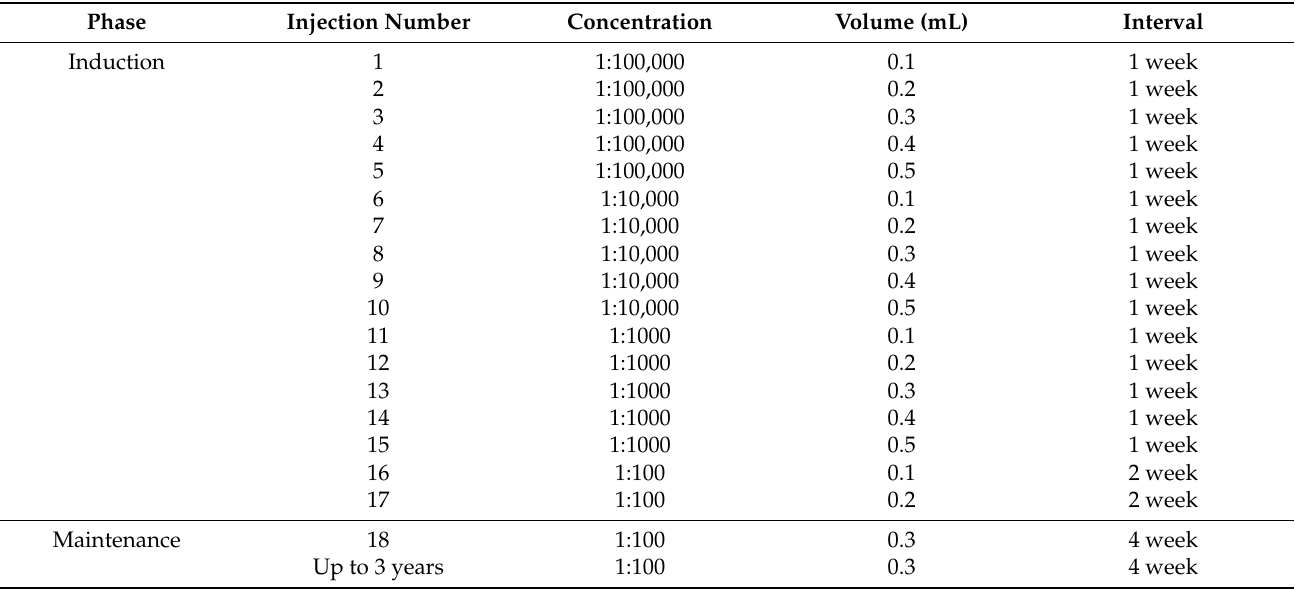
Table 2. The systemic reactions (e.g., generalized pruritus, urticaria, flushing, angioedema, shortness of breath, wheezing, sneezing, rhinorrhea, nasal pruritus, nasal congestion, itchy throat, cough conjunctivitis, nausea, and headache) from SCIT were found in only 11 events out of 2092 injections (0.0053 per injection) and no anaphylaxis